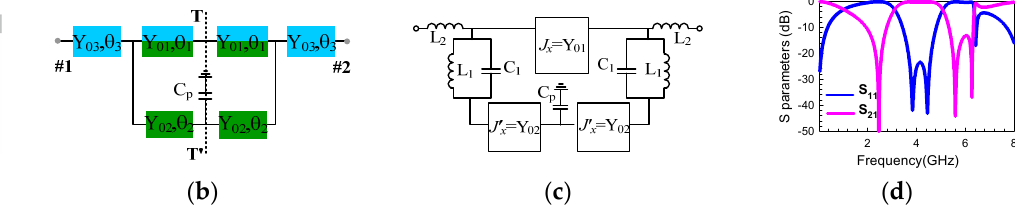
Figure 4. ( a ) A bandpass filter circuit by using a square loop resonator with perturbation element ( b ) TL model ( c ) LE model ( d ) frequency response.